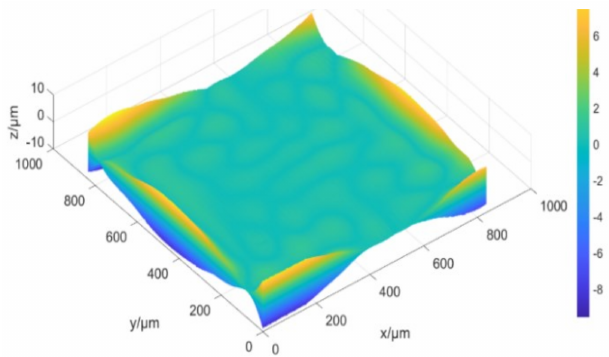
Figure 11. Profile of error surface of sinusoidal grid structures on a curved